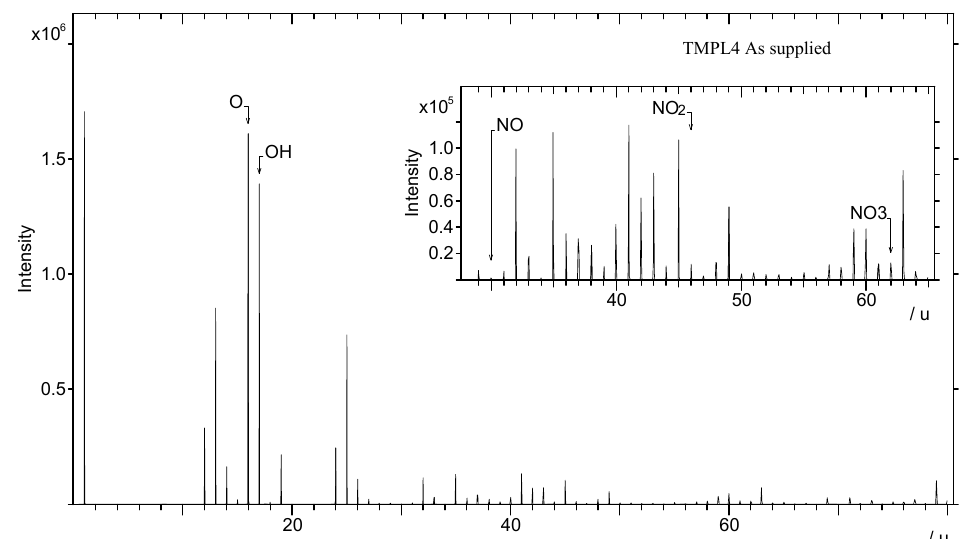
Figure 1. Material as supplied from the producer with TiO 2 , before the reaction of NO with UV. The sample does not show peaks assigned to NO, NO 2 , and NO 3 after the analysis with TOF-SIMS (in mass/unit) [12].